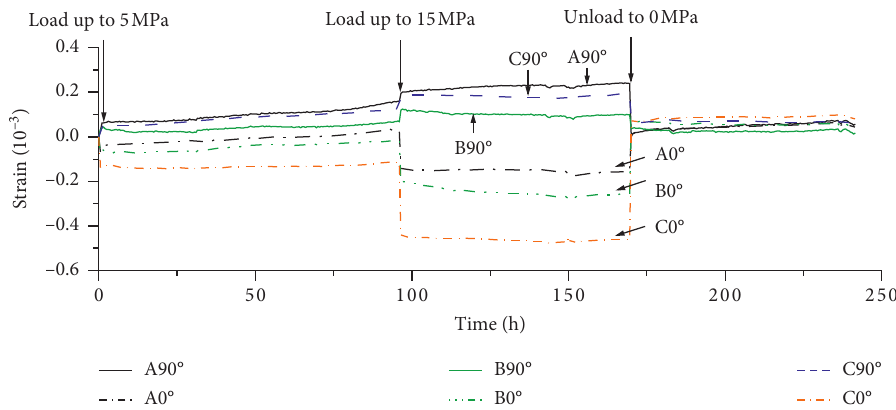
Figure 15: Time-effect strain under uniaxial loading and unloading of rock